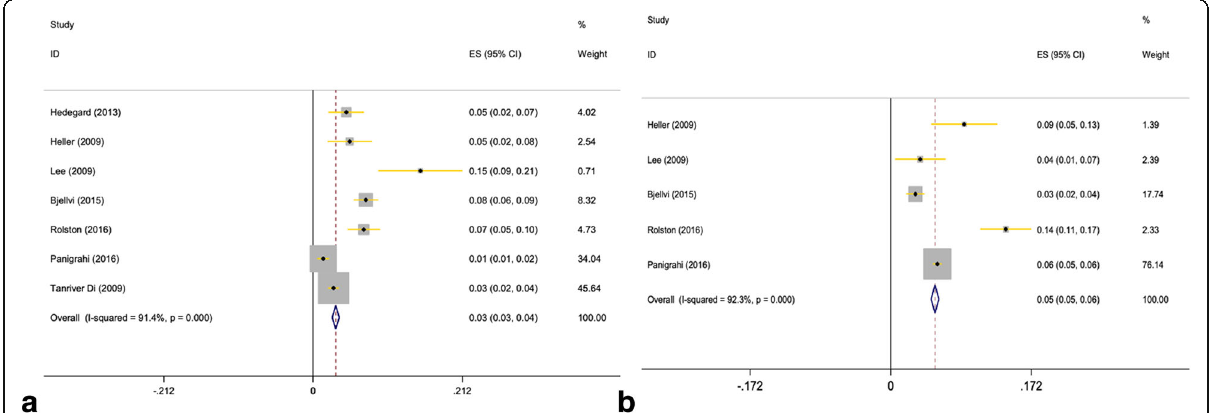
Fig. 6 The overall prevalence of minor ( a ) and major ( b ) complications of epilepsy